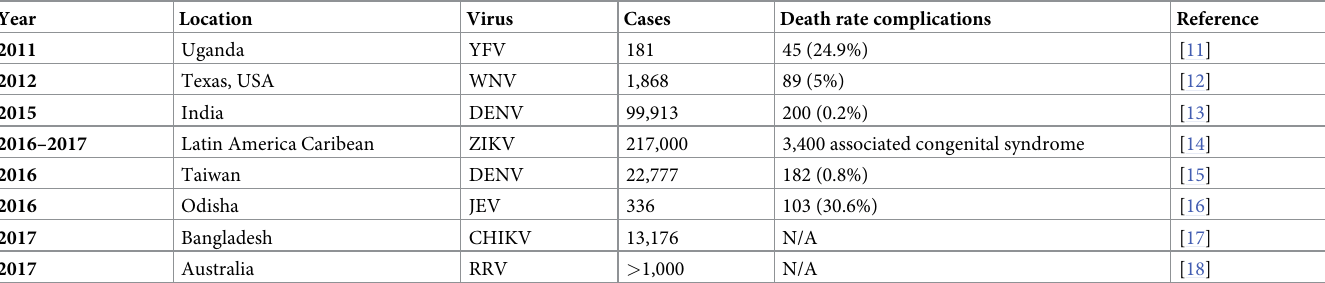
Table 1. Examples of recent flavivirus/alphavirus outbreaks